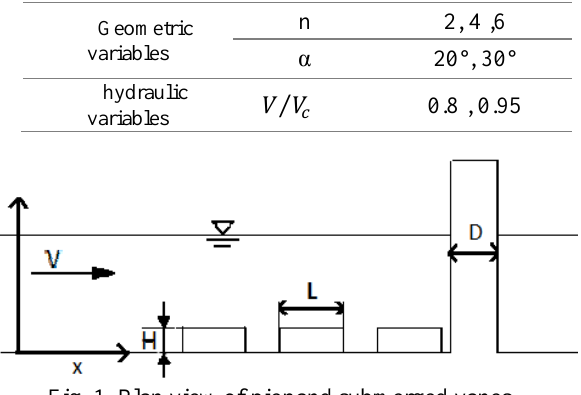
Table 1. The variable parameters in experiments submerged vanes in front of the base